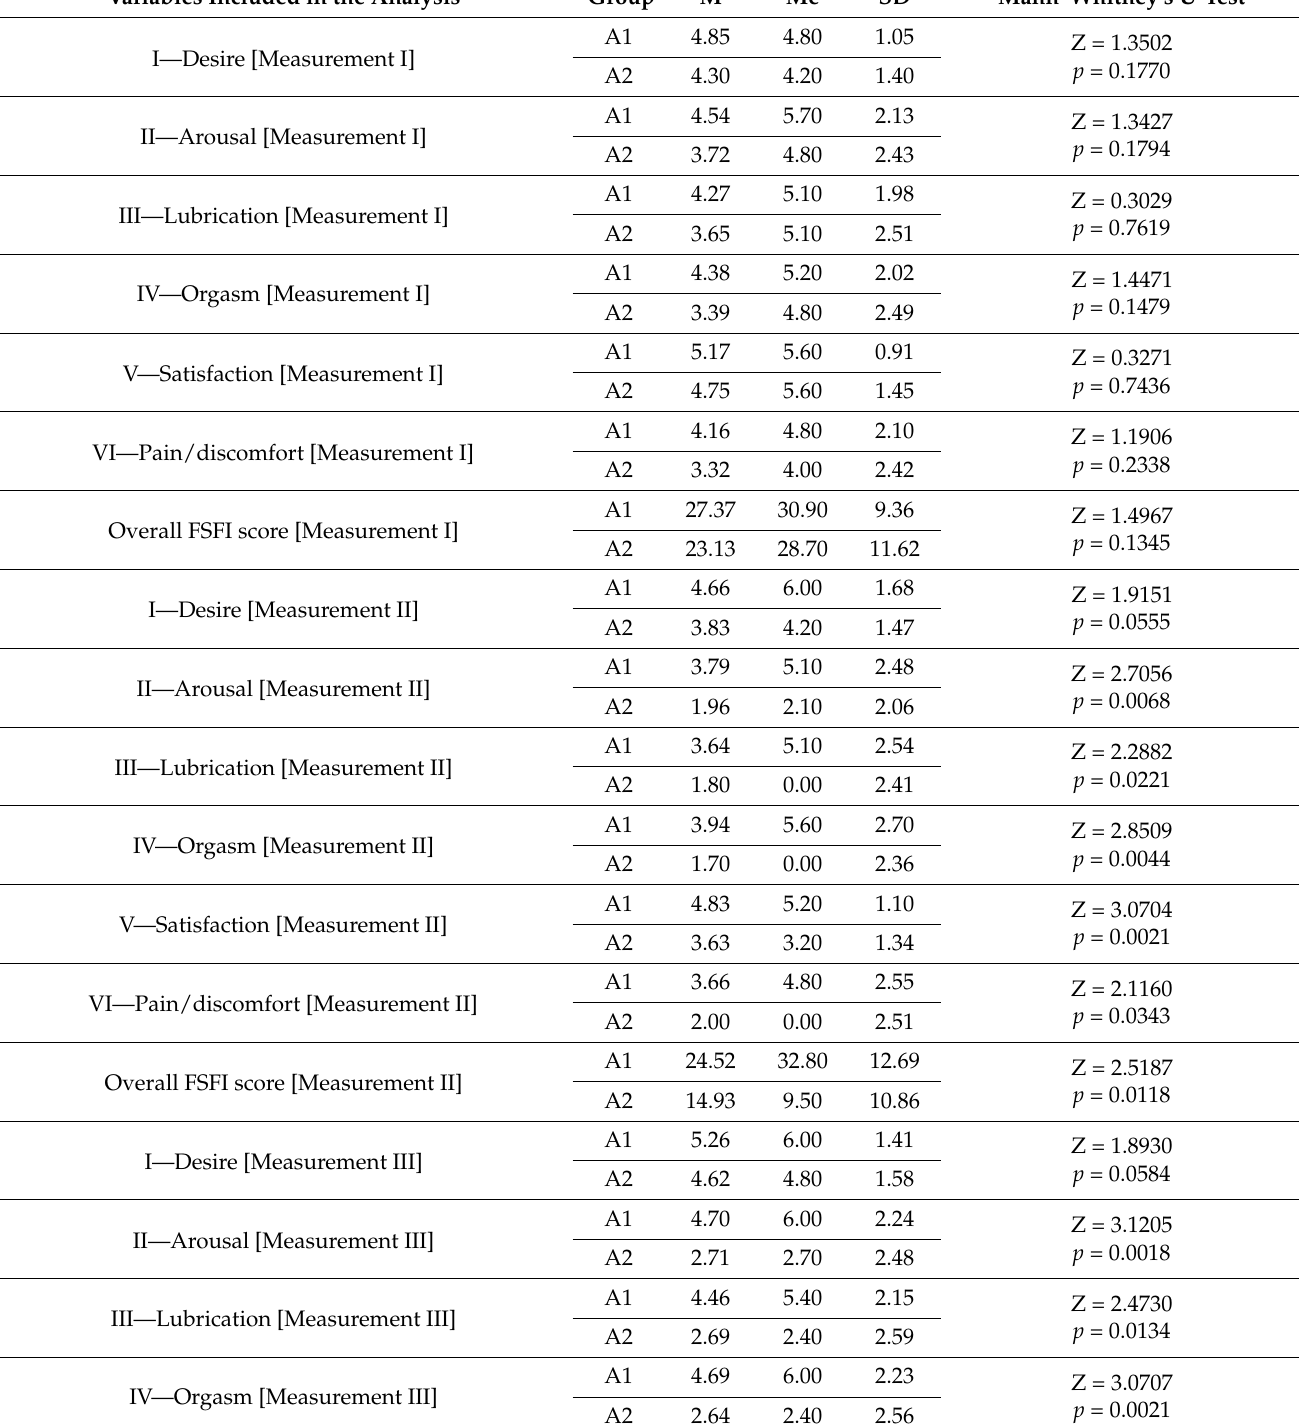
Table 3. FSFI scores in individual study